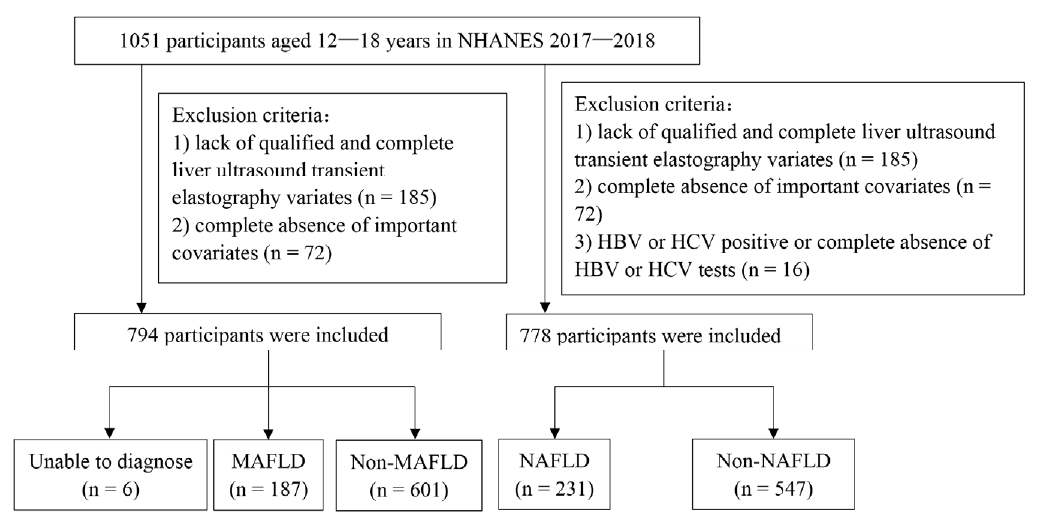
Figure 1. Flow chart of case selection in NHANES 2017–2018. The diagnosis of metabolic-associated fatty liver disease (MAFLD) is shown on the left. Participants with a positive diagnosis of hepatic steatosis who could not be diagnosed with MAFLD or non-MAFLD due to the omission of other indicators were classified as “Unable to diagnose”. The diagnosis of nonalcoholic fatty liver disease (NAFLD) is shown on the right. HBV, hepatitis B virus; HCV, hepatitis C virus.